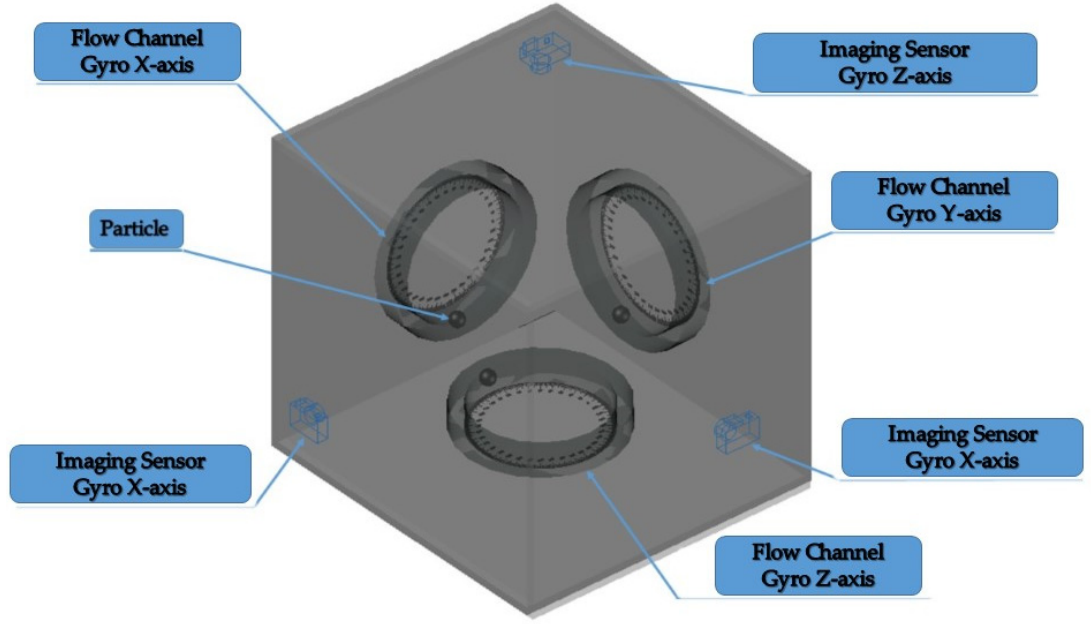
Figure 1. Schematic diagram of a particle imaging velocimetry gyroscope (PIVG) structure.